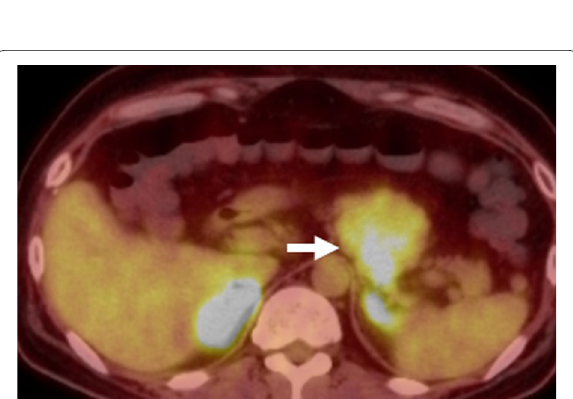
Fig. 4 FDG PET–CT imaging. FDG PET–CT reveals FDG deposition in the pancreatic tail: the maximum standardized uptake value is 16 (white arrow). FDG PET–CT: 2-[18F] fluoro-2-deoxy- d -glucose positron emission tomography computed